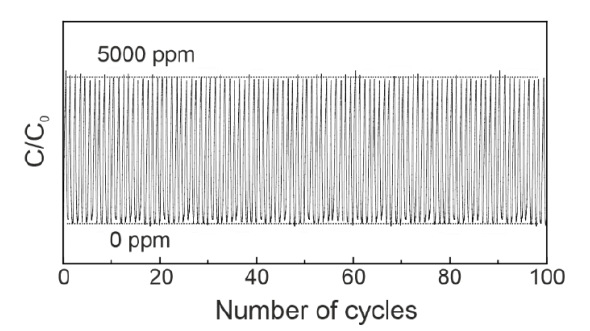
Figure 4. The recyclability test for adsorption and desorption of CO 2 at 45 ◦ C (50 mg, 5000 ppm CO 2 in He balance: 200 mL/min, pure He: 200